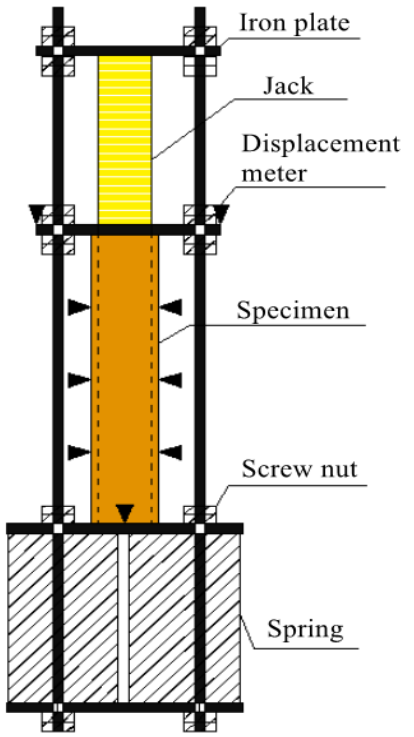
Figure 4. Schematic diagram of loading device.